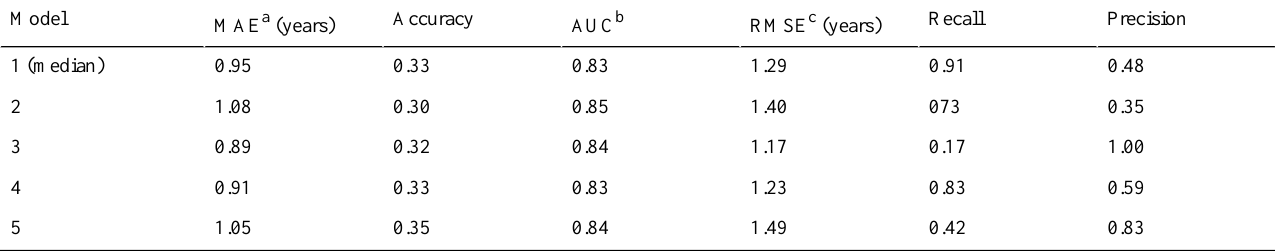
Table 11. Performance results for the multi-layer perceptron algorithm on each of the outer cross-validation test sets, for the male sample.